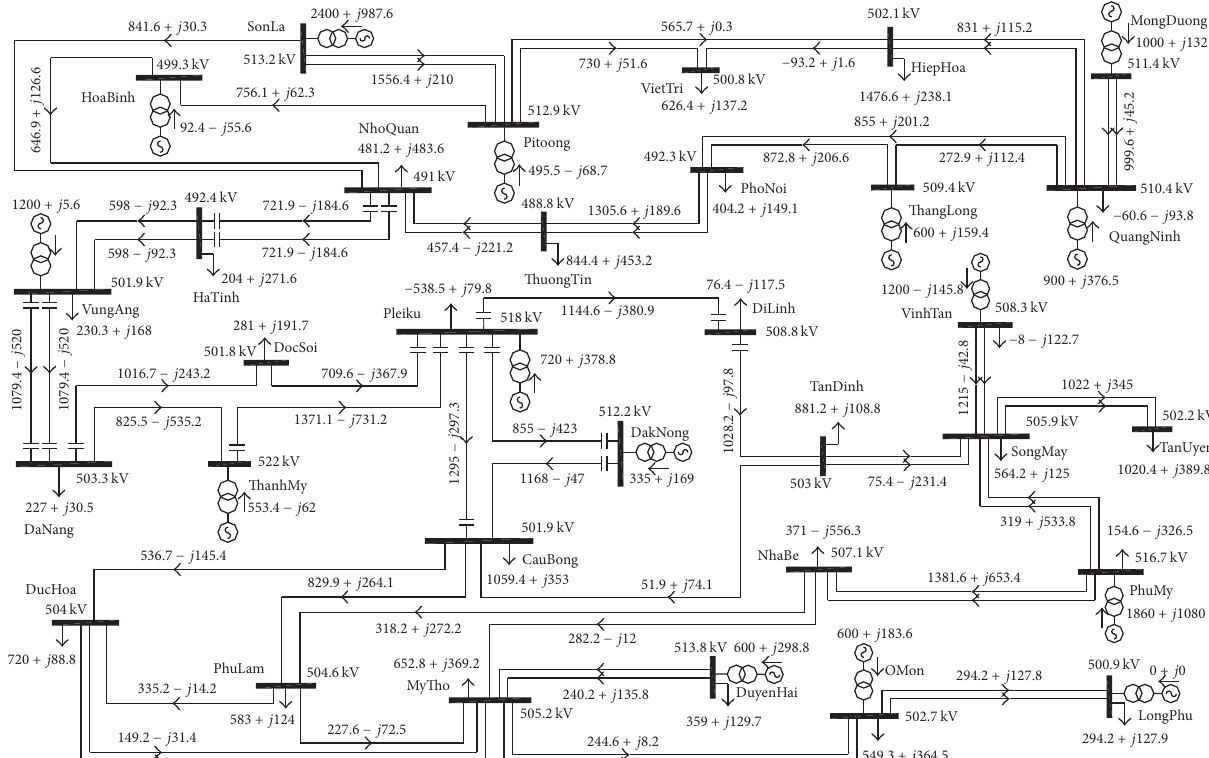
Figure 2: The result of load flow calculation on the Vietnamese 500/220 kV power system